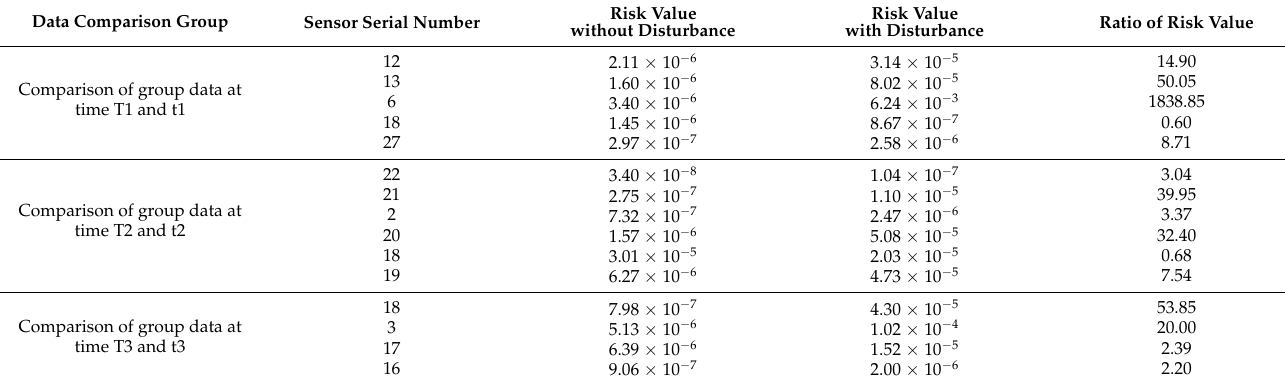
Table 5. Comparison and summary of inspection